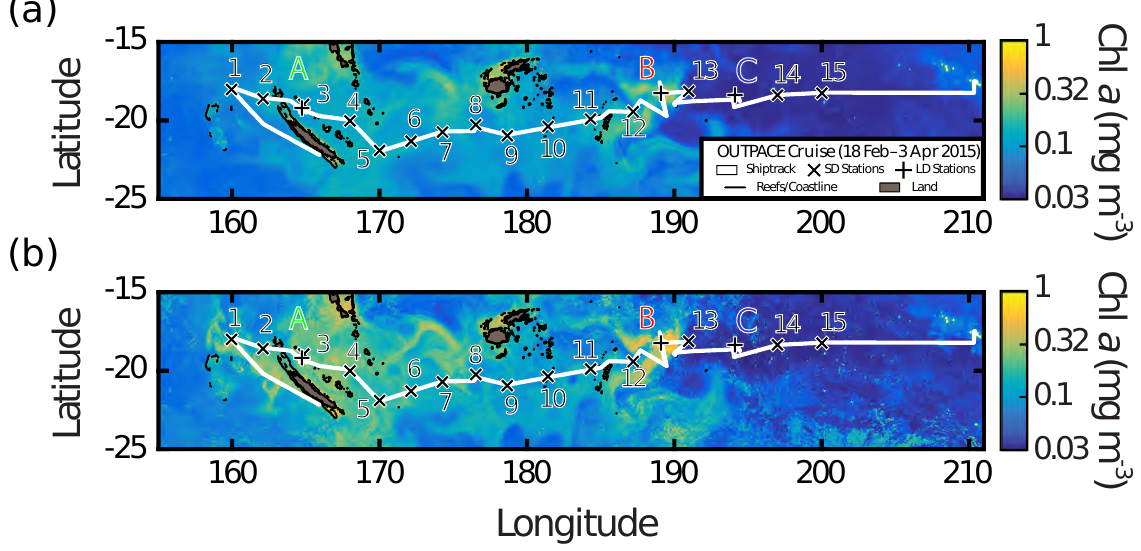
Figure 2. Transect of the OUTPACE cruise superimposed on (a) arithmetic mean surface chl a and (b) quasi-Lagrangian weighted mean chl a of the WTSP during OUTPACE. The two types of station, short duration (X) and long ( + ) duration, investigated for a period longer than 7 days, are indicated. The satellite data are weighted in time by each pixel’s distance from the ship’s average daily position for the entire cruise. The white line shows the vessel route (data from the hull-mounted acoustic Doppler current profiler (ADCP) positioning system). Coral reefs and coastlines are shown in black, land is grey, and areas of no data are left white. The ocean color satellite products are produced by CLS with support from